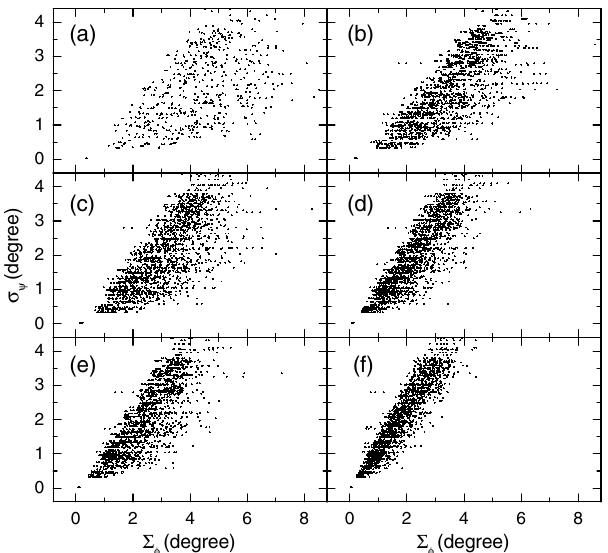
FIG. 8. Correlation plots between Σ ϕ and σ ψ in the conditions (a) –